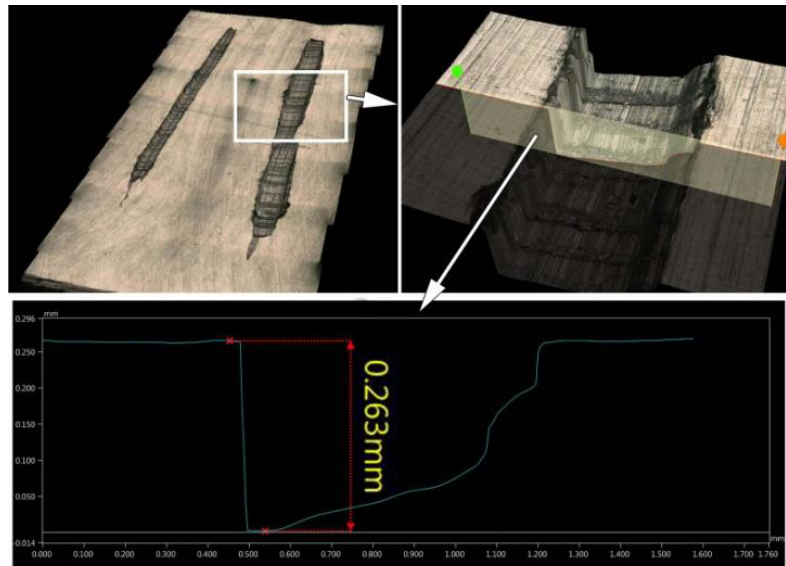
Figure 7. Measurement of surface defect depth.